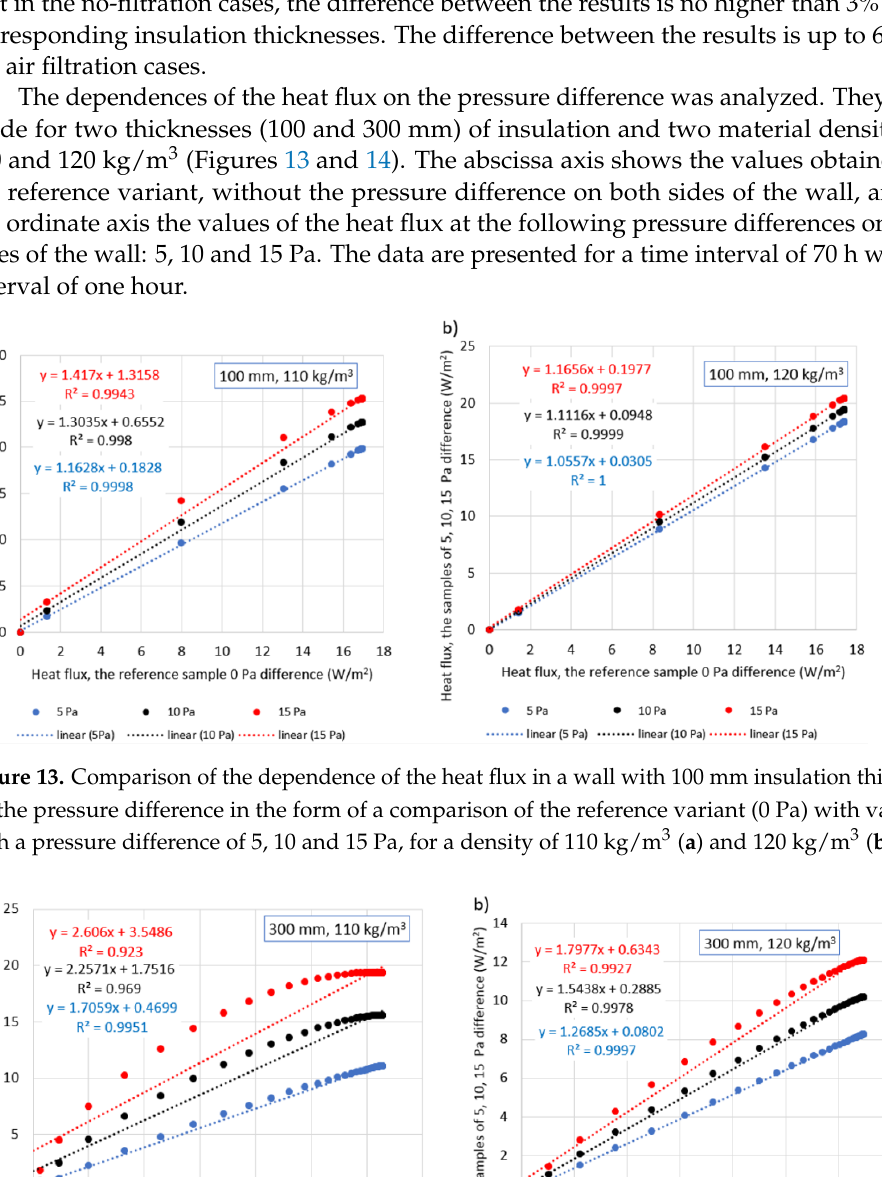
Figure 12. Heat conduction flux through the wall with 300 mm thickness of hemp fiber insulation with density of: 110 kg/m 3 ( a ) and 120 kg/m 3 ( b ) .